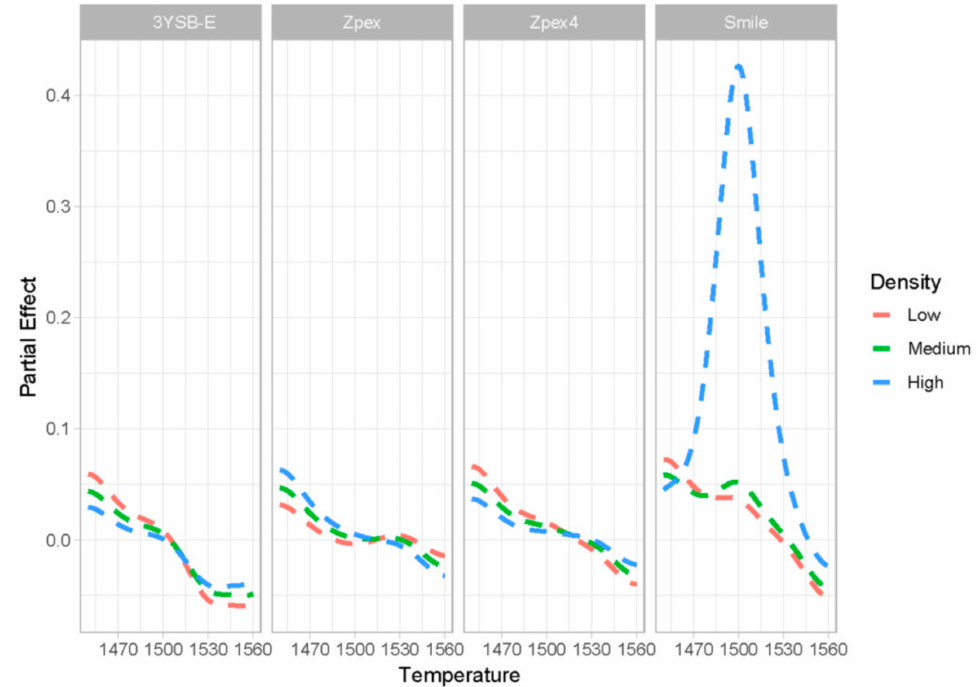
Figure 8. Partial e ff ect of the sintering temperature for each of the zirconia types and with di ff erent values of apparent